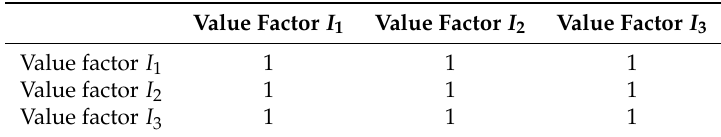
Table 9. Decision matrix of I 0 relating to a reference point.